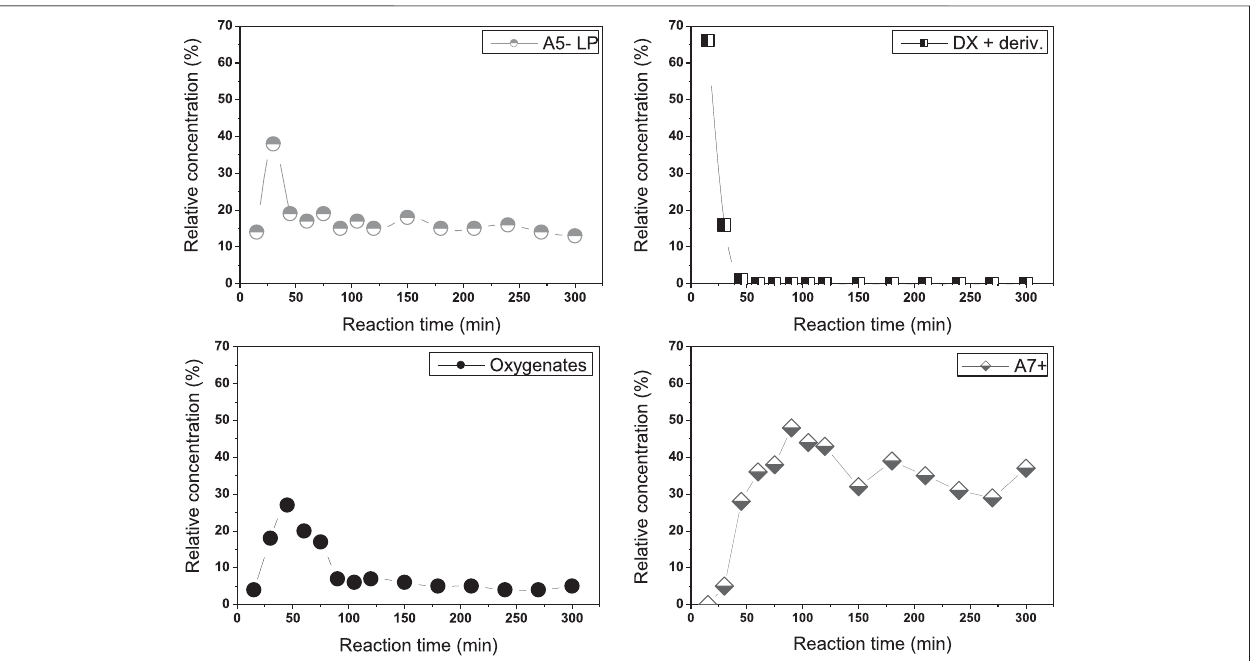
FIGURE 6 | Relative concentrations of different classes of products (% of total carbon of the liquid) obtained from the hydroconversion of 5 g of DX in 90 g of n-hexane using 10 g of Pd/HBEA at 250 ° C under 30 bar of H 2 . Aliquots were withdrawn from the liquid phase at time intervals of 15 min. A5 − LP (cid:1) alkane with fi ve or fewer carbons in liquid phase; A7+ (cid:1) alkane with seven or more carbons; DX + deriv. (cid:1) DX derivatives (ketal carbohydrates containing four and fi ve oxygens); oxygenates (cid:1) oxygenated products (mainly mono-oxygenated compounds like ketones, furfurals, and alcohols).